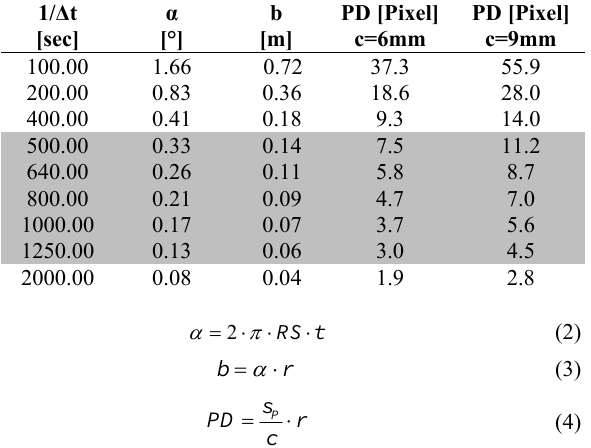
Table 3: Relation between exposure time and UAS-rotation induced pixel displacements